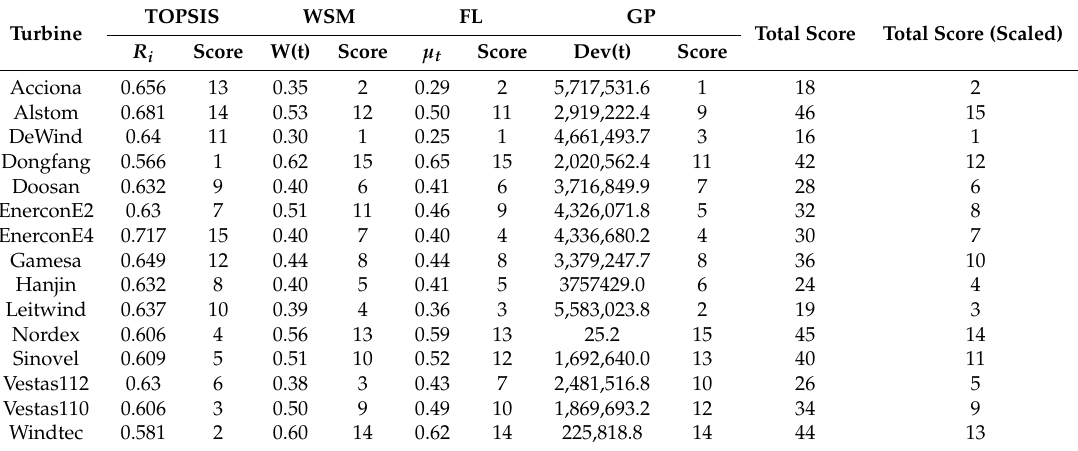
Table 6. The scores in terms of different methods for